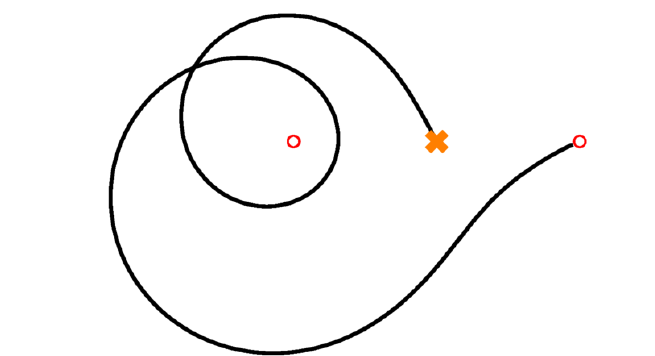
Figure 54. Bound state of the D4- with the D0 brane at non-zero